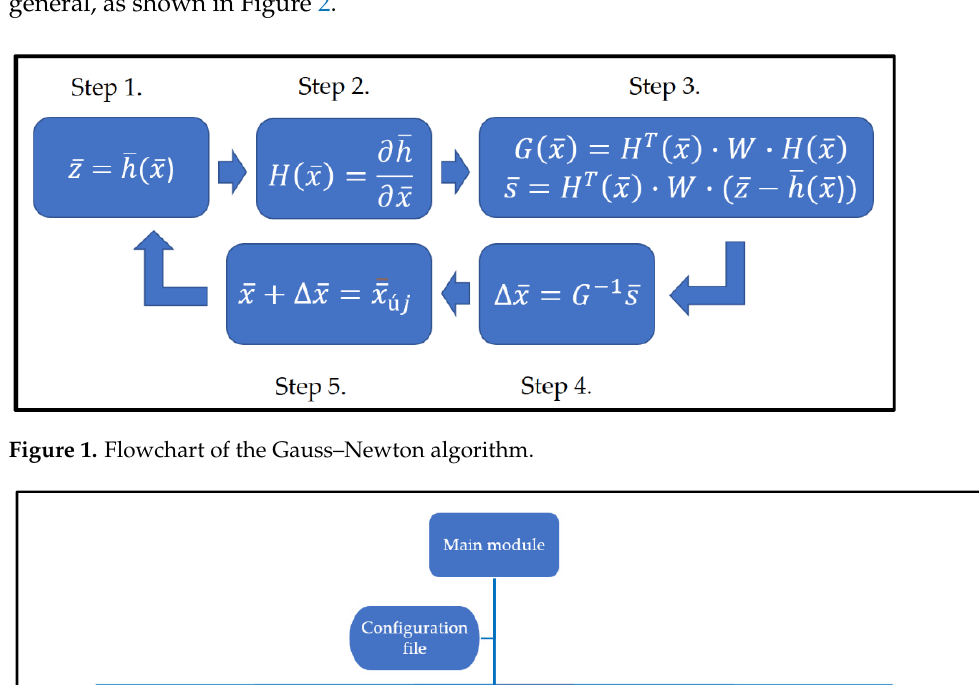
Figure 1 . Flowchart of the Gauss–Newton algorithm.